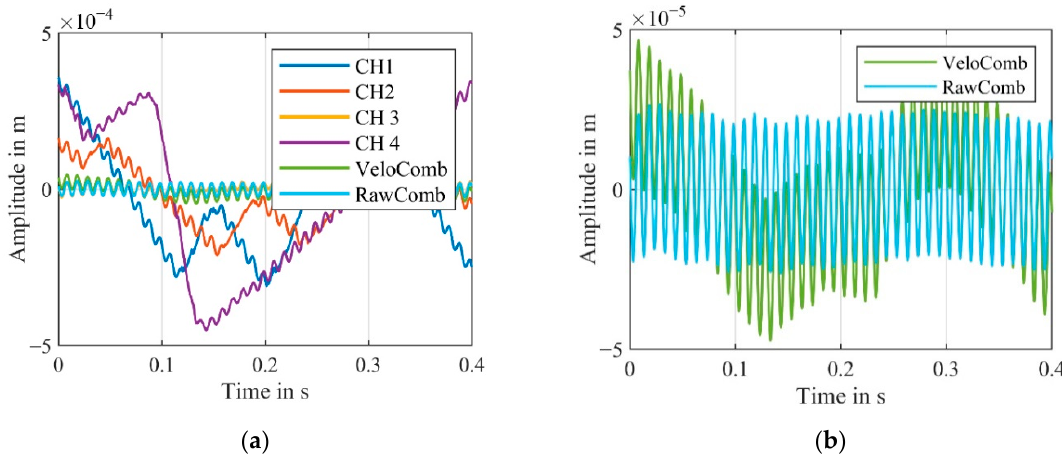
Figure 12. ( a ) Comparison of the demodulated displacement signals of the four channels CH1–CH4 as well as the combined signals derived from the old and new algorithms; (RBW = 2.5 Hz). ( b ) Magnified section of the combined signals from ( a ) to illustrate the difference.